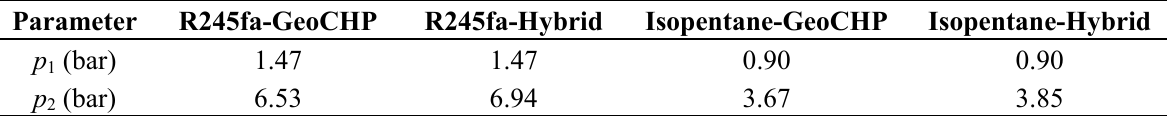
Table 4. Condensation and evaporation